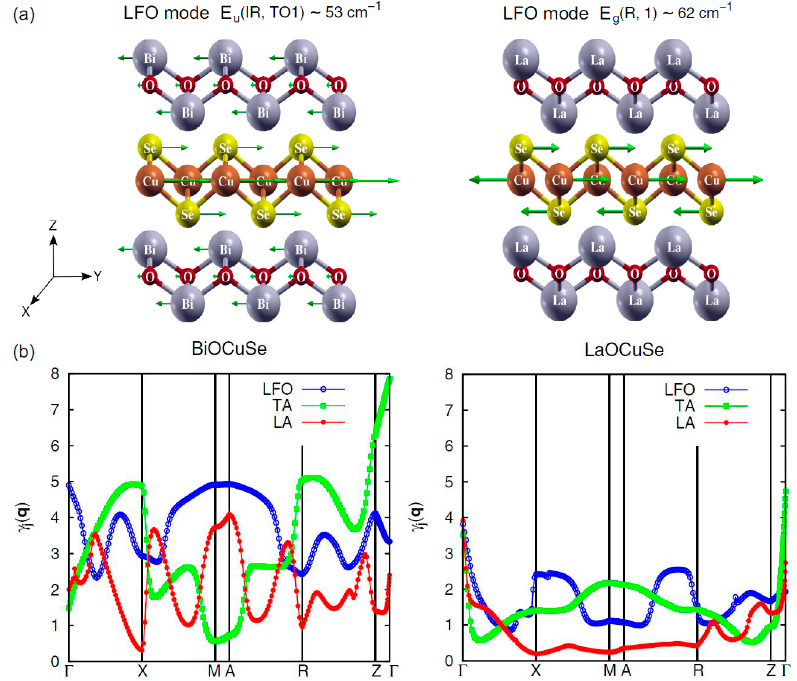
Figure 5. ( a ) Atomic displacement patterns Eu (IR,TO1) ~ 53 cm − 1 and Eg (R,1) ~ 62 cm − 1 for the respective lowest-frequency optical (LFO) mode in BiCuSeO ( left ) and in LaCuSeO ( right ), arrows represent the atomic movement directions; ( b ) Mode Grüneisen dispersion of the above LFO mode (blue) in comparison to that of the longitudinal acoustic (red) and transverse acoustic (green) movement in BiCuSeO ( left ) and in LaCuSeO ( right ), respectively. Reproduced with permission from Reference [47]. Copyright 2015, The American Physical Society.